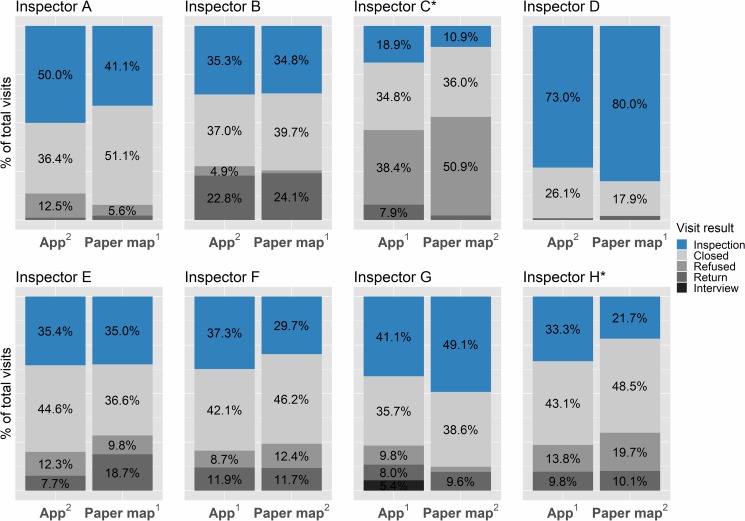
Visit outcome distributions.Inspections shown in blue, visit outcomes making up the ‘other’ category shown in shades of grey. Letters A-H refer to the corresponding inspector. *Significantly higher proportion of houses inspected when using the app (Fisher’s exact test, p<0.05).